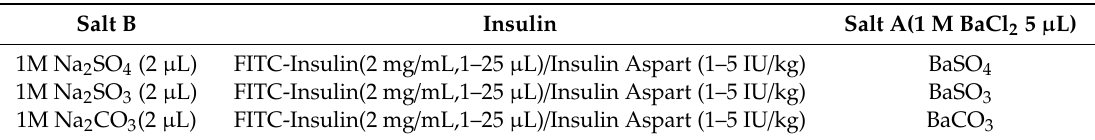
Table 2. Ba salt particle formulations loaded with insulin.